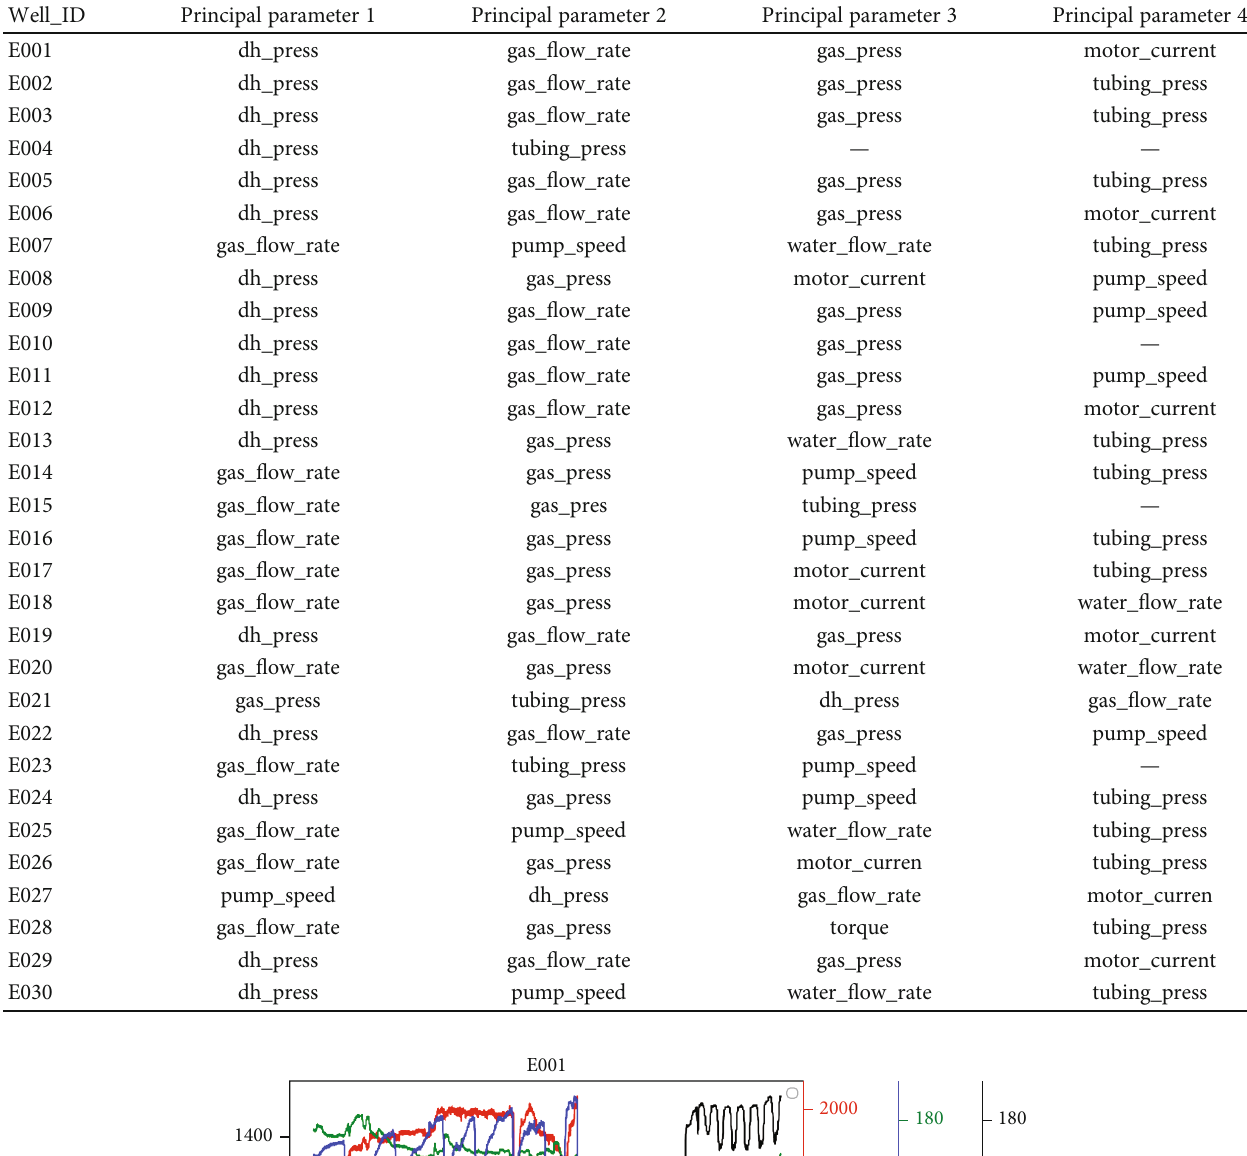
Table 4: Principal parameters of 30 failure wells.